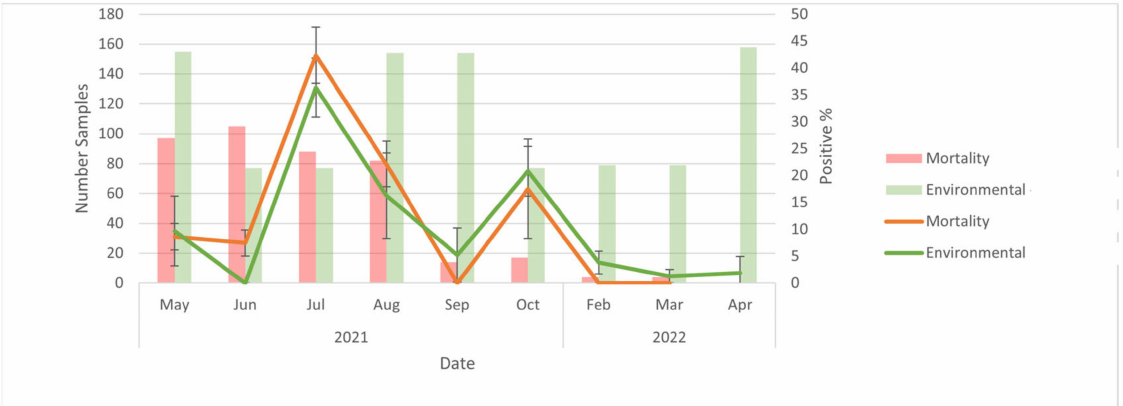
Figure 3. Comparison of environmental and mortality samples from May 2021 to April 2022. No mortalities were sampled after 2022-02-11 because the farm was depopulated.